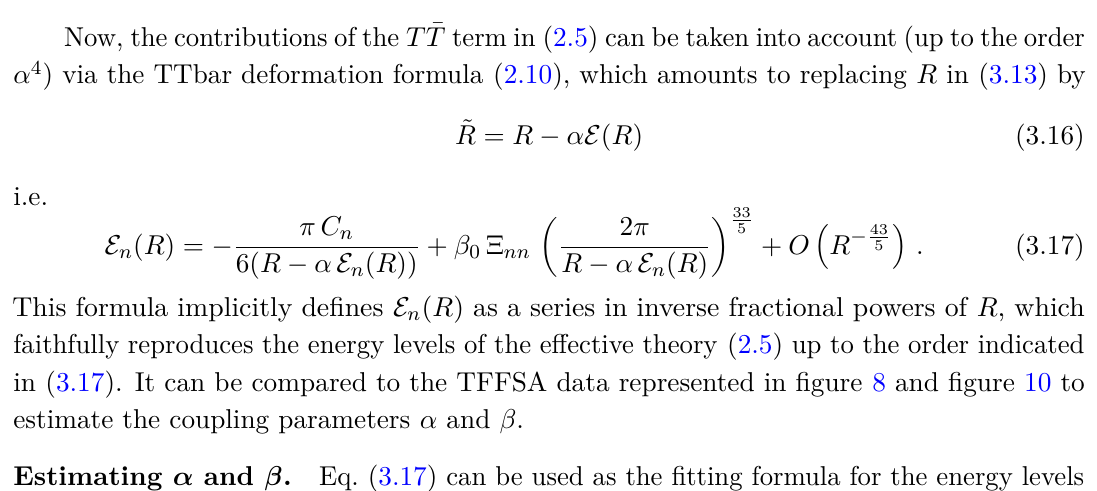
Figure 7 . Plots of TFFSA data for C 0 ( R ) (in red line), and the plots of (3.18) against ˜ R (TTbar- undressed C (0) ( R ) ), with few sample values of α 0 0